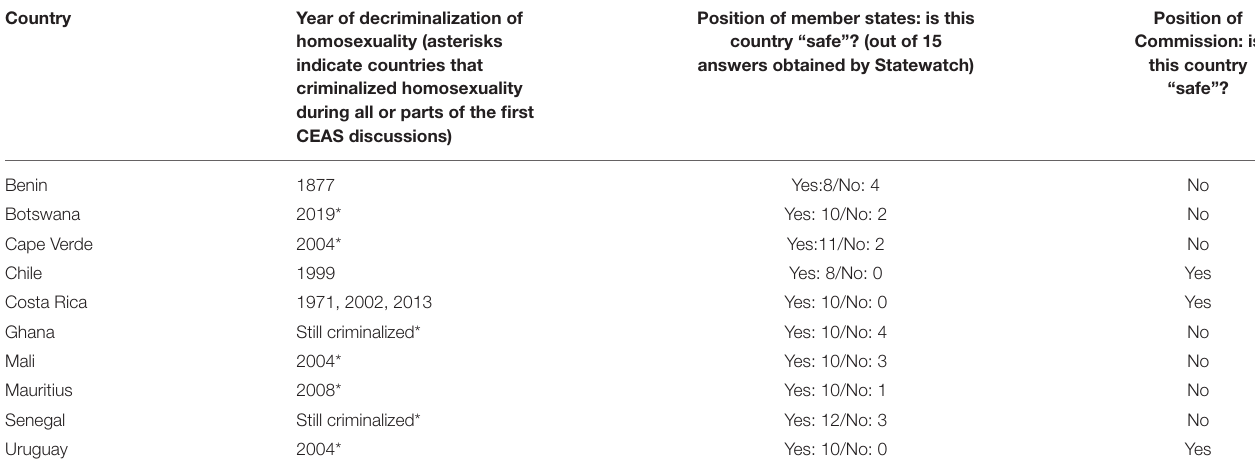
Position of member states: is this country “safe”? (out of